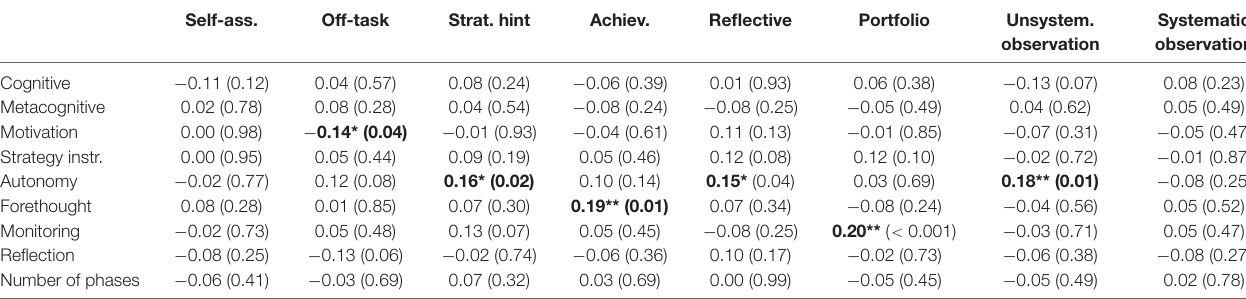
Systematic observation observation